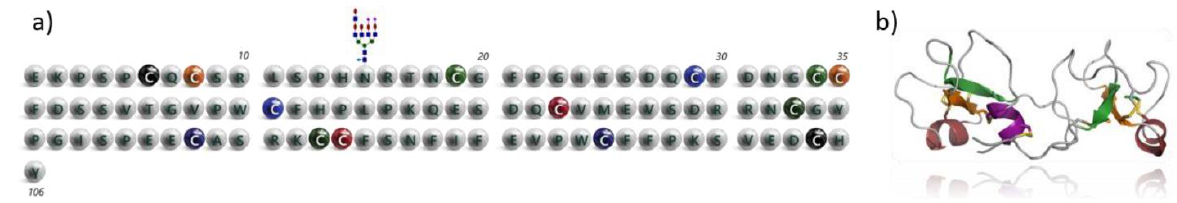
Figure 27. hTFF2: ( a ) sequence, ( b ) structure modelled after homologous porcine TFF2. 4.23. The Royal Jelly Fatty Acid 10h2da Inhibits Migratory and Invasive Potential of Colorectal Cancer Cell Lines (P23)